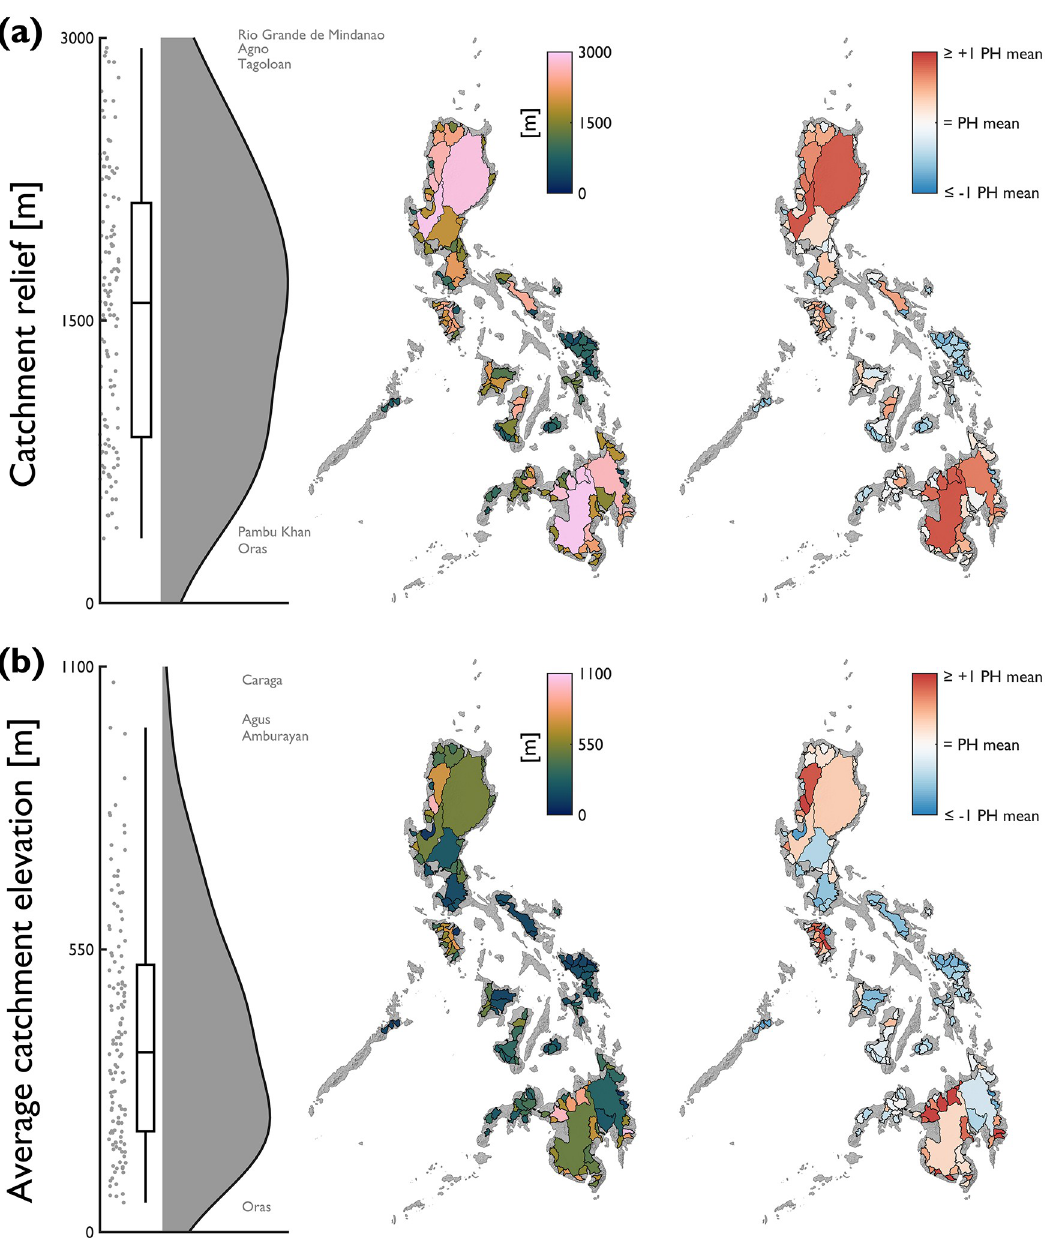
Fig 5. National-scale assessment of elevation characteristics, including: (a) catchment relief; and, (b) average catchment elevation. Note that for the red-blue choropleth map, values are displayed relative to the Philippine average for each attribute (catchment relief = 1563 m; average catchment elevation = 385 m). Annotations on the raincloud plots denote catchments with notably high/low characteristics.